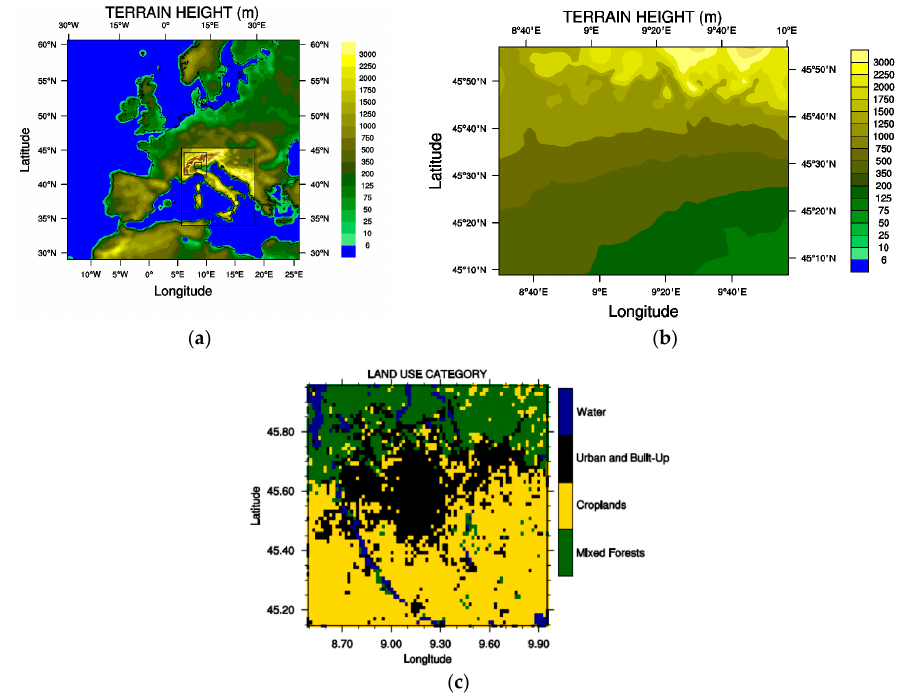
Figure 1. Simulation domains: ( a ) terrain height for the one-nested domains; ( b ) terrain height for the high-resolution domain; ( c ) land use classification from MODIS for the highest resolution domain.